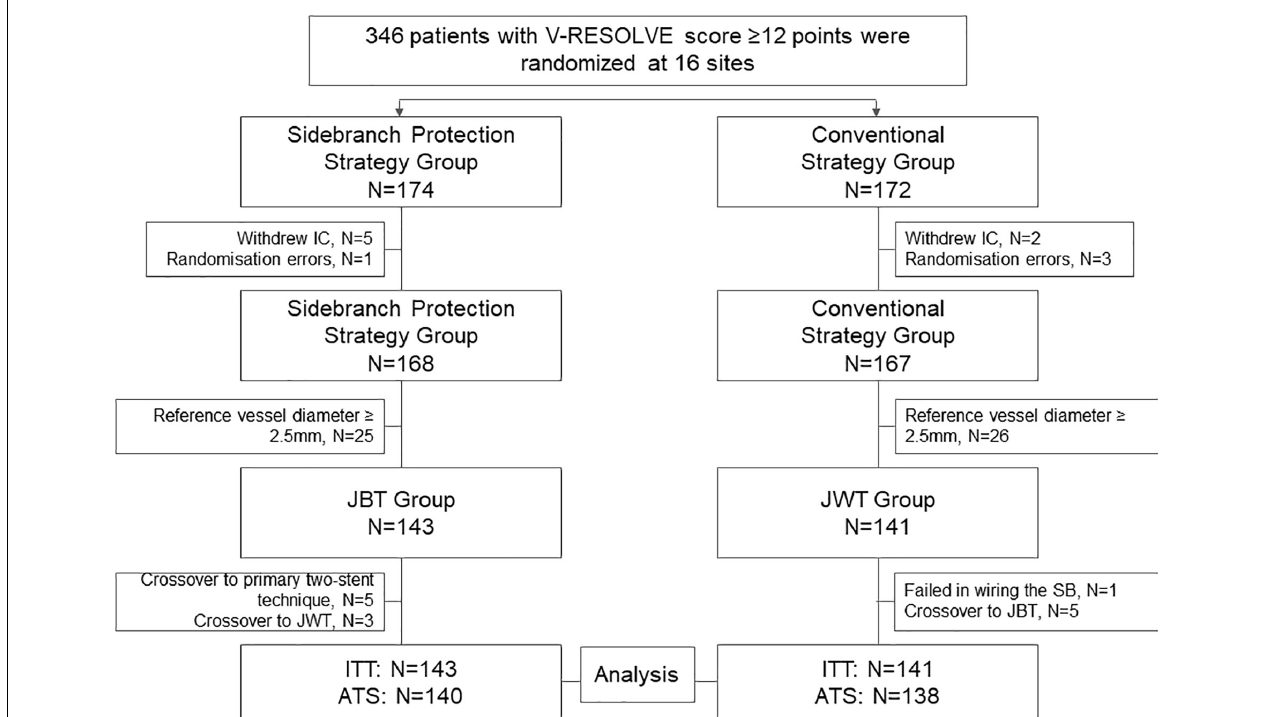
FIGURE 1 | Study population. From December 2016 to April 2019, a total of 335 subjects were randomly assigned to the active strategy group ( n = 168) or conventional strategy group ( n = 167). Among them, 143 patients in the active strategy group have an SB with 2 mm ≤ RVD < 2.5 mm and were assigned to JBT accordingly, while 141 patients in the conventional strategy group have an SB with 2 mm ≤ RVD < 2.5 mm and were assigned to JWT. For the ATS, 140 patients underwent the JBT strategy and 138 patients underwent the JWT strategy. IC, informed content; JBT, jailed balloon technique; JWT, jailed wire technique; ITT, intention to treat; ATS, as treated